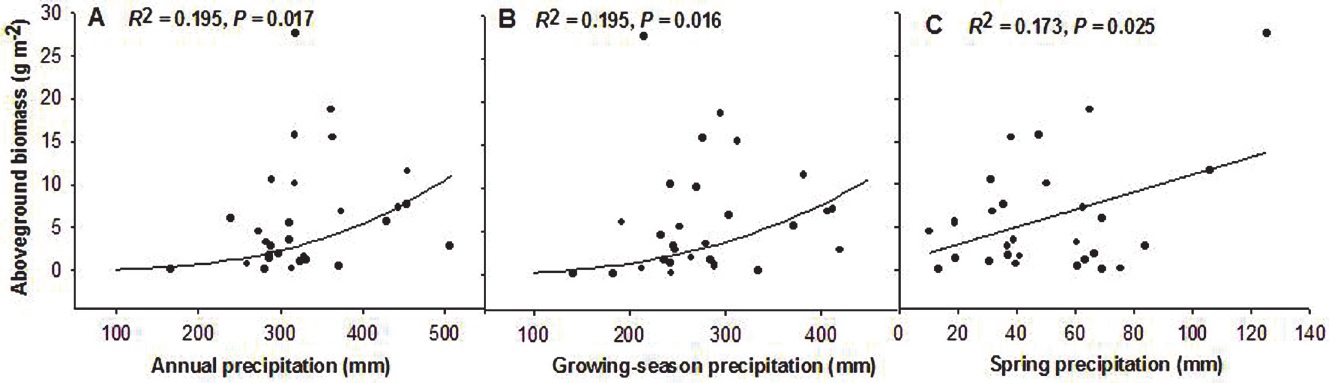
Fig 2. Relationship between aboveground biomass of annuals and precipitation, using data from 1982 to 2012. (A) Annual precipitation; (B) Growing- season precipitation; (C) Spring precipitation.